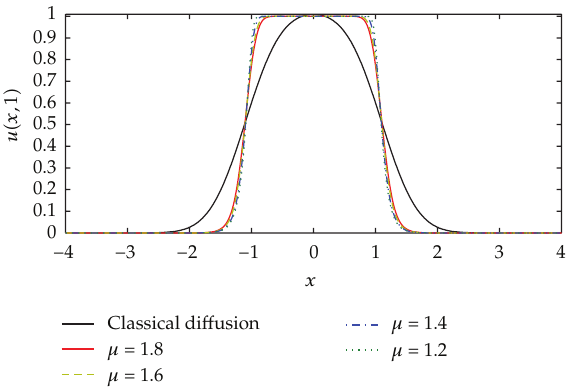
Figure 7: Numerical solutions for (cid:3) 5.5 (cid:5) and (cid:3) 5.11 (cid:5) with λ (cid:8) 0 .